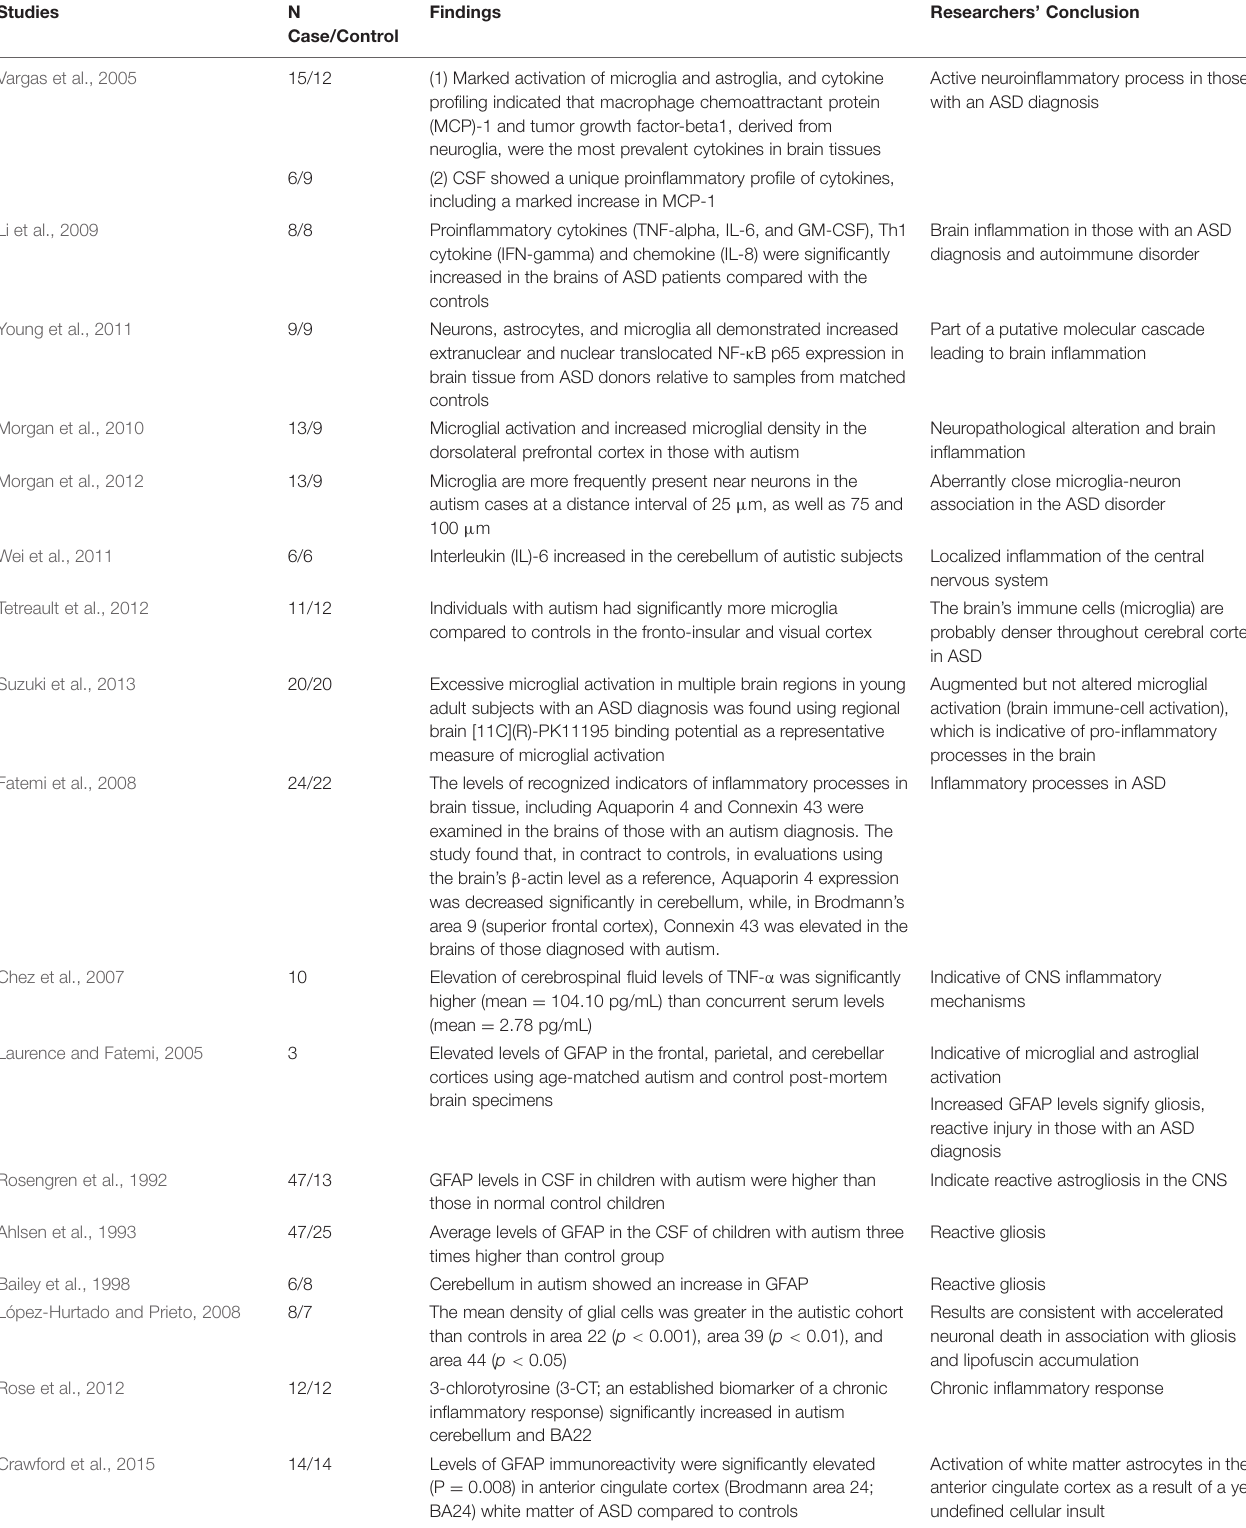
TABLE 1 | Evidence of neuroinflammation/encephalitis in the brains and cerebral spinal fluid (CSF) of subjects with autism spectrum disorder (ASD).